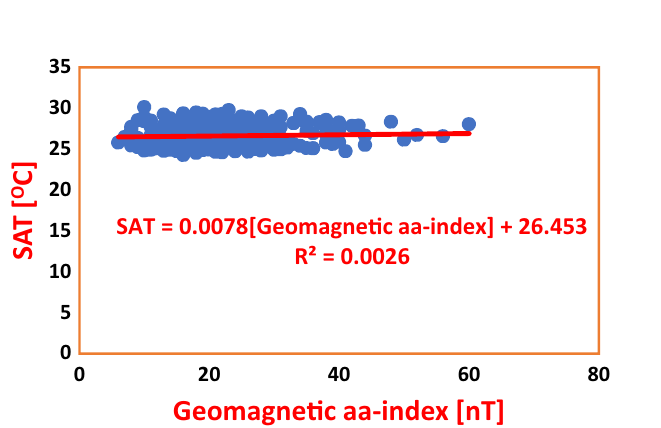
Figure 7. Regression of Geomagnetic aa-index on SAT in ABD during Solar Cycles 22–24. The model shows that an increase of Geomagnetic aa-index by 1 nT effected an increase in SAT by mere 0.0078 °C. Also, the Coefficient of Determination is too small to cause a tangible effect in variability of SAT.